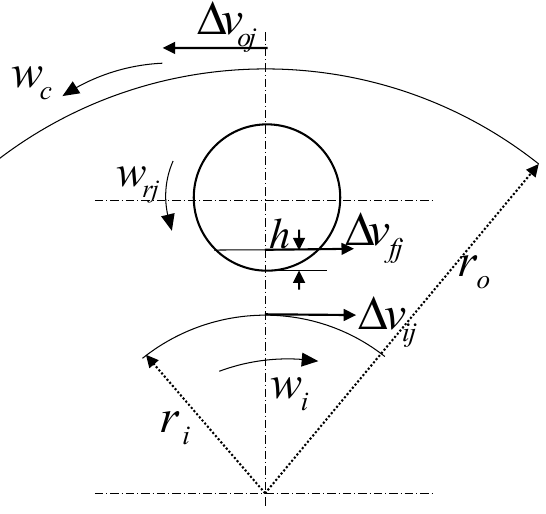
Figure 4. Movement relation.